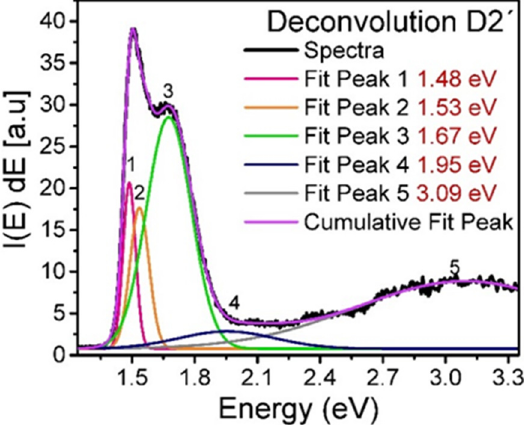
Figure 9. Photoluminescence spectrum deconvolved for the D2´ film.